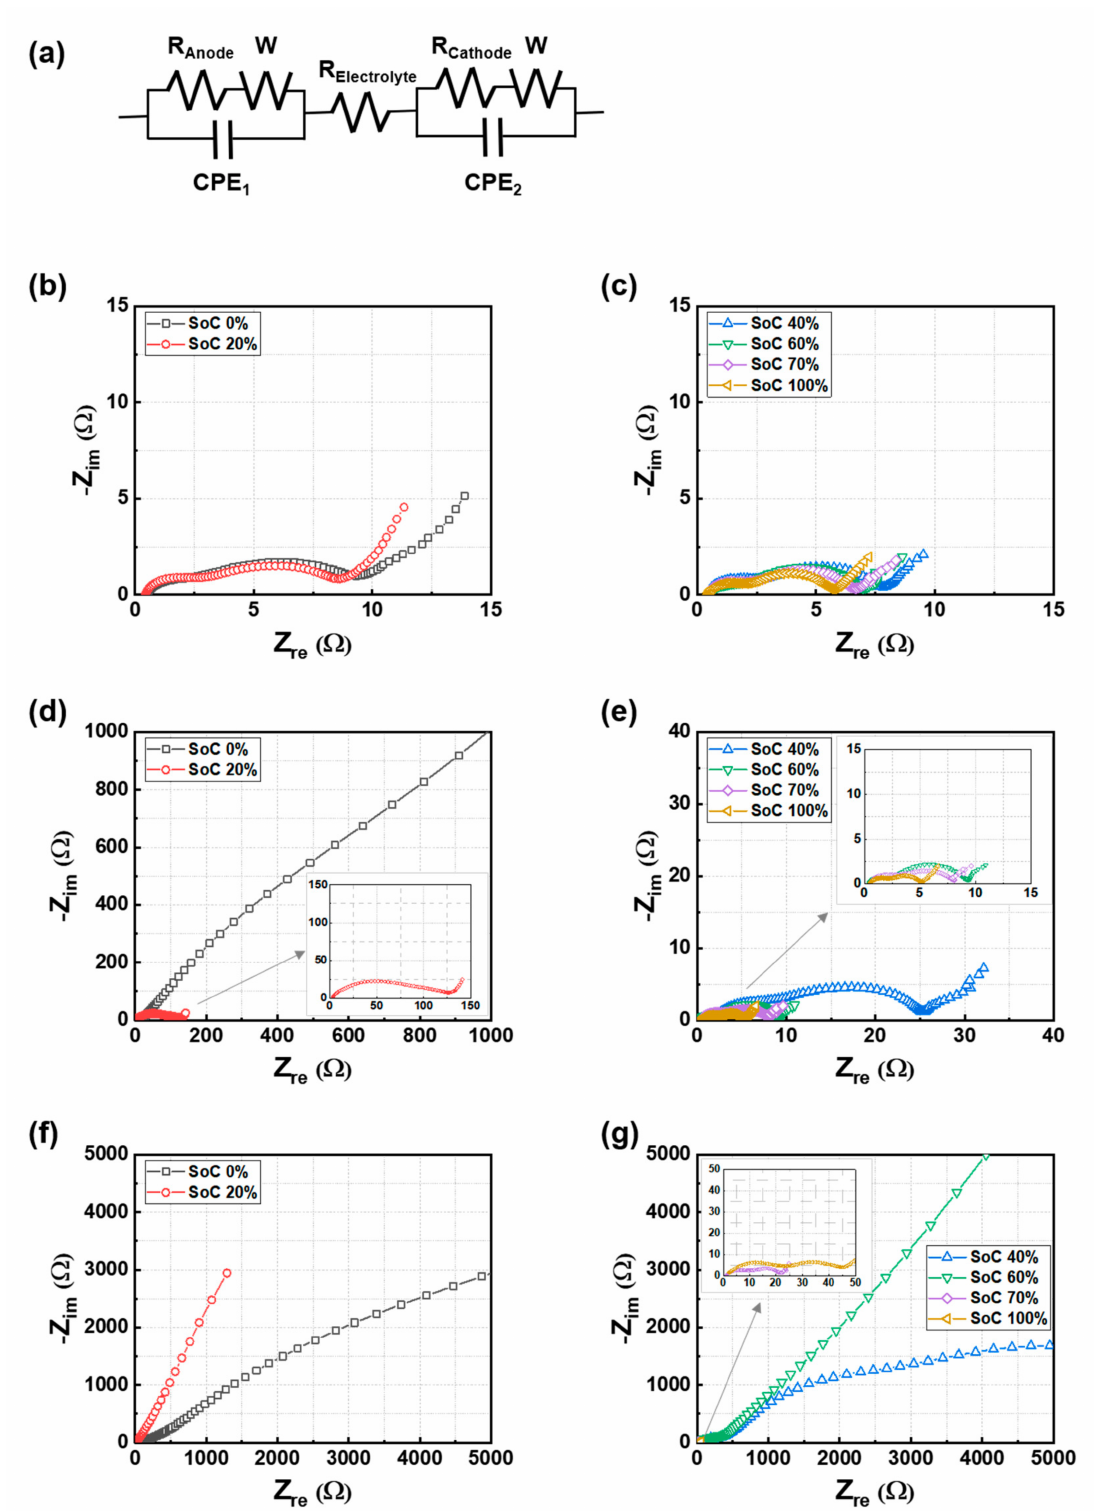
Figure 5. ( a ) Equivalent electrical circuit and the Nyquist plots for the different SoC cells under the conditions of ( b , c ) as-received, ( d , e ) after the fatigue test, and ( f , g ) after the fatigue and cycling